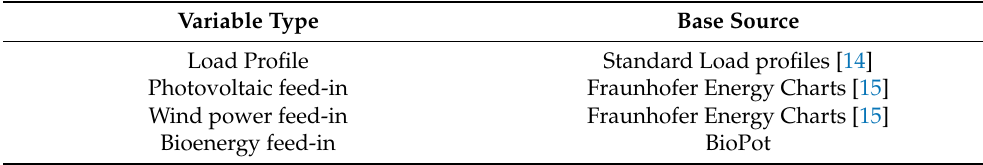
Table 1. Variables included in the analysis. All variables are time series in 15-min resolution for one exemplary year (2018) in